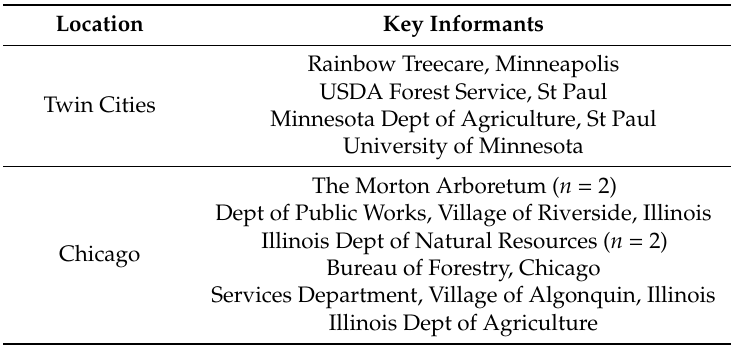
Table 1. Organizations (and key informants within) consulted to gather data on emerald ash borer (EAB) management in the two